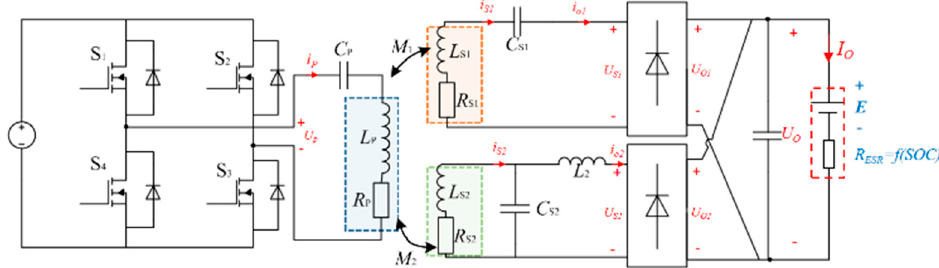
Figure 11. Schematic diagram of the proposed system.